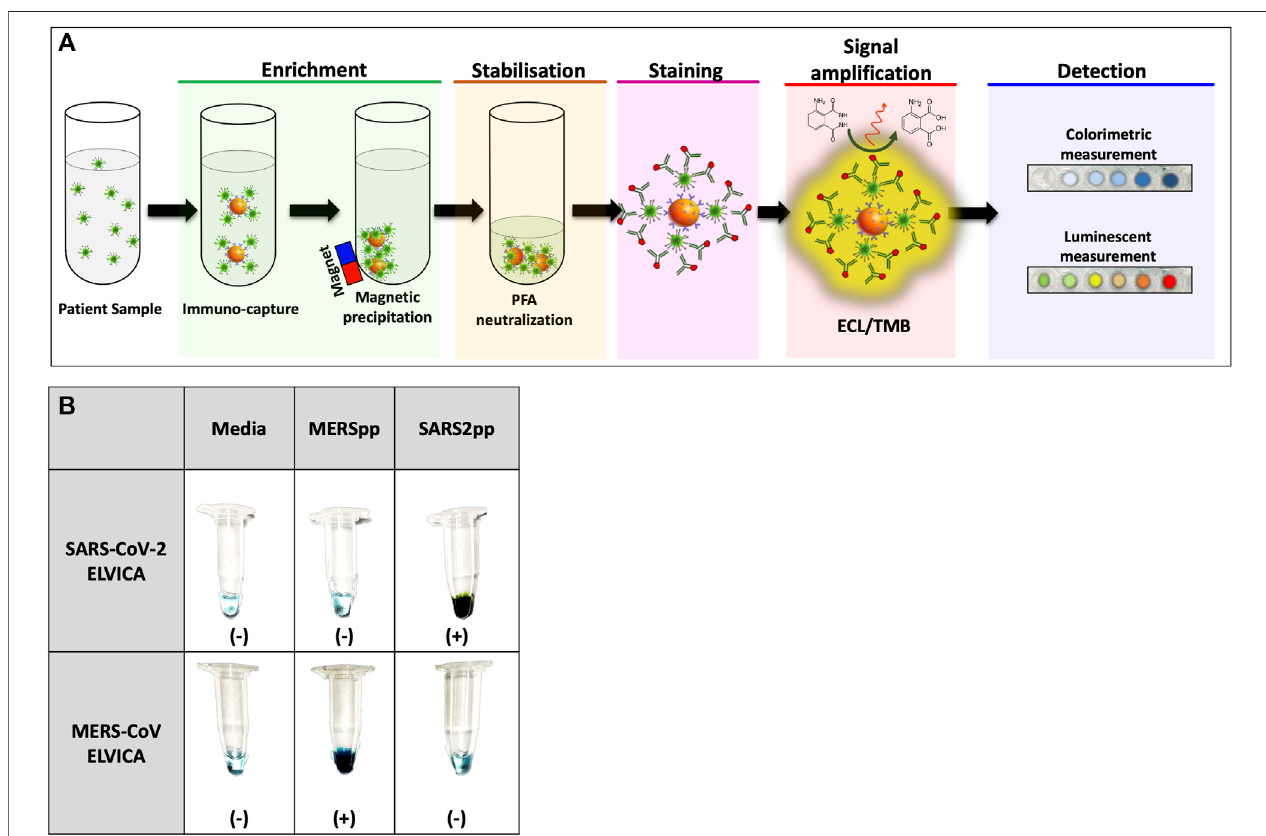
FIGURE1| Representationofthesequential stepsandvisualizationofELVICA test. (A) ELVICAtest consists of fi veconsecutivesteps: enrichmentofviralparticles by magnetic immune capture; stabilization of immune-captured viral particles with paraformaldehyde (PFA); staining of immune-captured viral particles with highly speci fi canti-spikeantibody;developmentofsignalampli fi cationbyECLorTMBsubstratesofHRP;andsignaldetectionusingcolorimetricorluminescentmeasurement. (B) Visualization of colorimetric ELVICA in tubes for SARS2pp and MERSpp; ELVICA was performed on media, SARSpp, or MERSpp. HRP: horse radish peroxidase. ECL: enhanced chemiluminescence substrate. TMB: 3,3 ′ ,5,5 ′